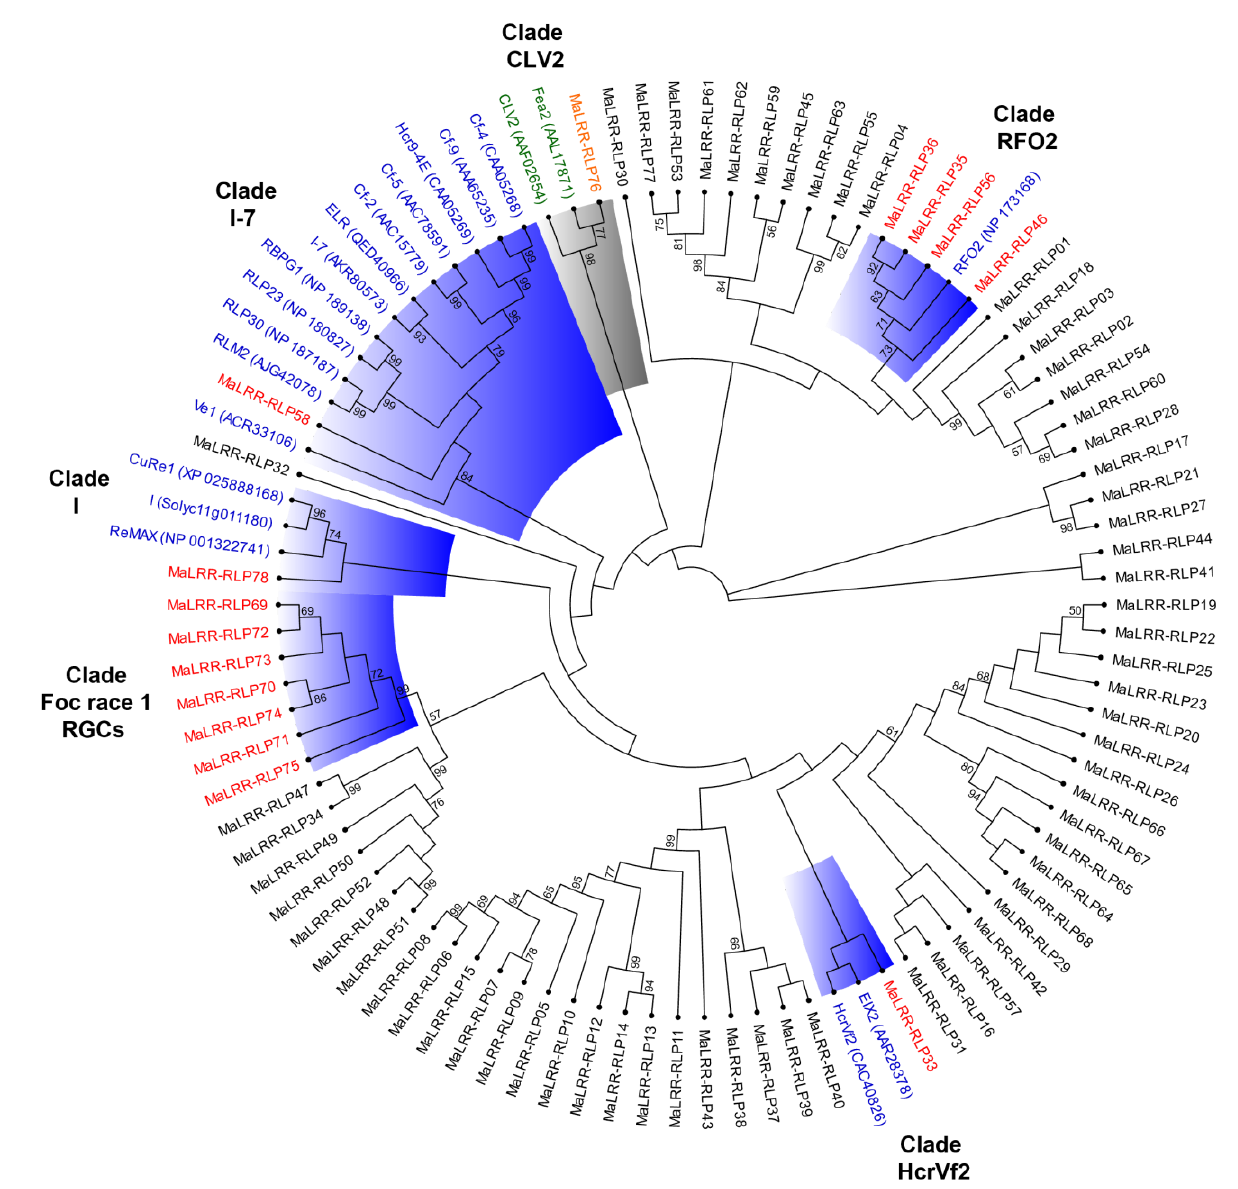
Figure 5. Maximum likelihood phylogenetic tree of the banana LRR-RLP family and LRR-RLPs from different plant species involved in disease resistance or development. The names and accession numbers (in parentheses) of LRR-RLPs involved in plant immunity or development are highlighted in blue or green, respectively. Banana LRR-RLP resistance gene candidates or with a potential role in development are highlighted in red or orange, respectively. Clades containing MaLRR-RLP RGCs are highlighted in blue. Numbers on the branches indicate the percentage of 100 bootstrap replications supporting the particular nodes, and only those ≥ 50% are shown. The C3-F region of LRR-RLP proteins was used for phylogenetic tree construction.